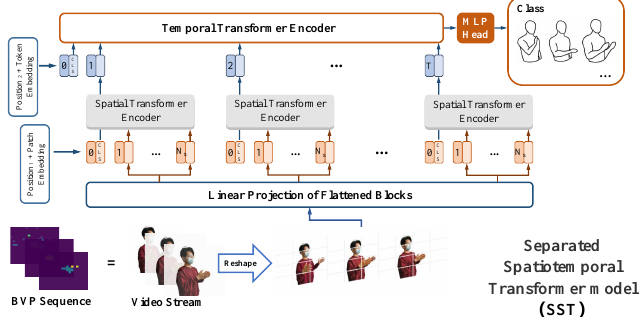
Figure 8. Separated spatiotemporal transformer model.